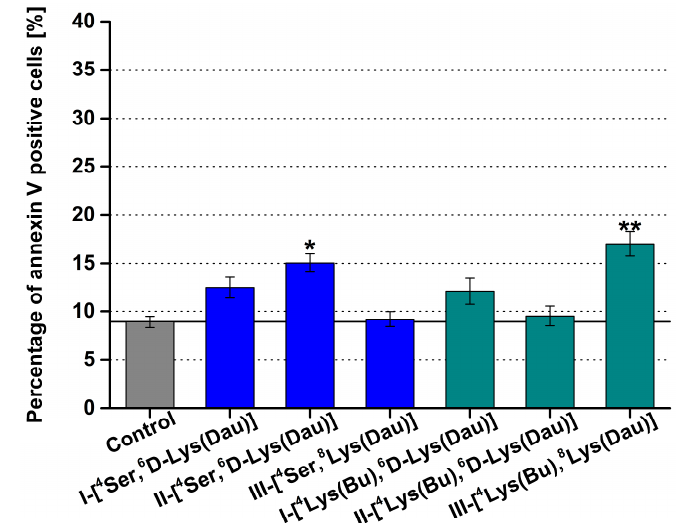
Figure 2. Results of the flow cytometric study of the apoptosis induced by the GnRH conjugates with 4 Ser or 4 Lys(Bu). For the treatment, the conjugates were applied at 10 − 4 M concentration for 24 h. Only the viable cells were taken into consideration to determine the percentage of annexin V-positive cells. Two independent experiments were carried out by using two parallels, and representative data are shown. Data shown are mean of two parallels ± SD. The significance levels are the following: *: p < 0.05, **: p < 0.01.